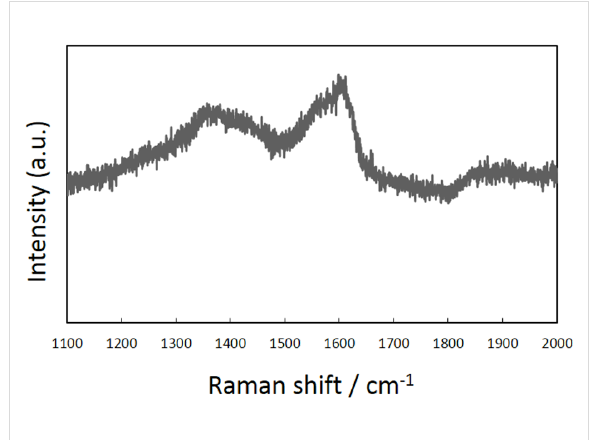
Figure 5: Raman shift measured for the sample, providing evidence of the existence of amorphous carbon.